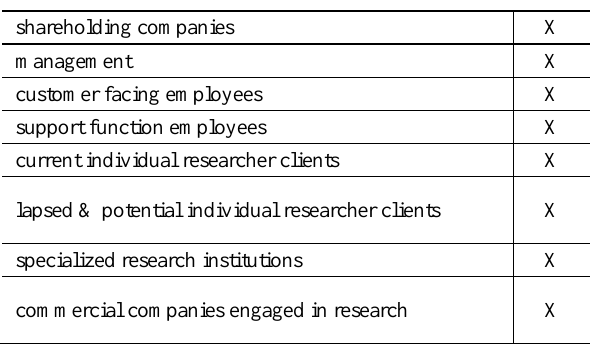
Table 4: Participants loading on Factor 1